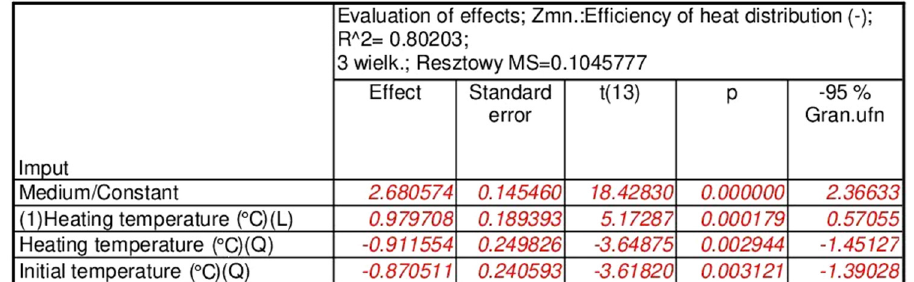
Figure 16. ( a ) Pareto chart for all input quantities of interest and their correlation to the output quantity value; ( b ) Pareto chart for the statistically significant input quantities, applicable to the PCM/copper conductor heat accumulator.